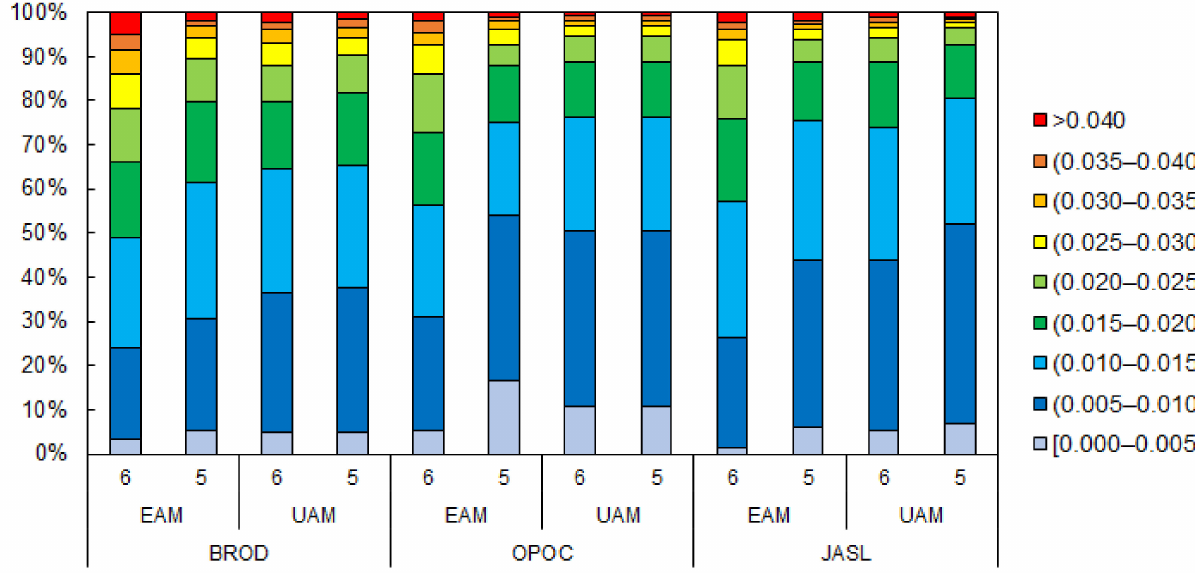
Figure 7. Classification of 3D distances from determined positions to reference positions for the standard approach (EAM) and the proposed modification (UAM) by